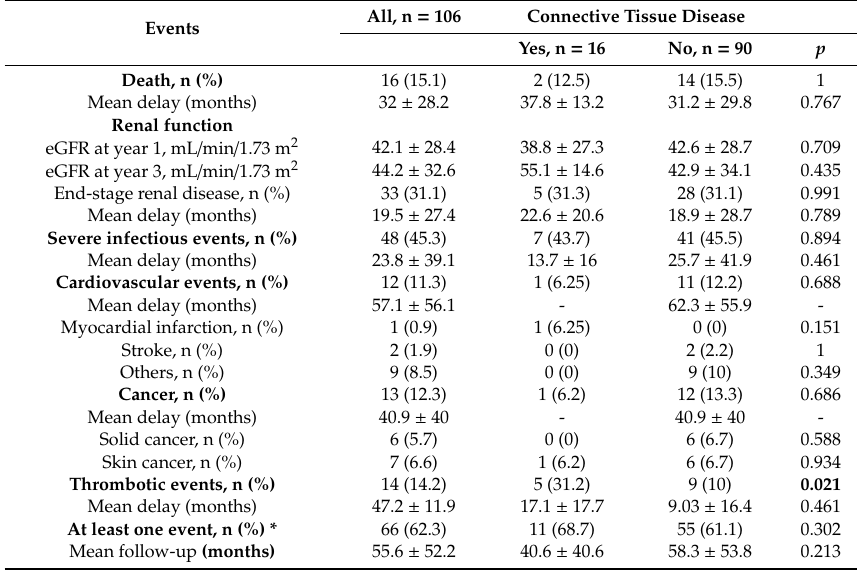
Table 6. Outcomes according to study